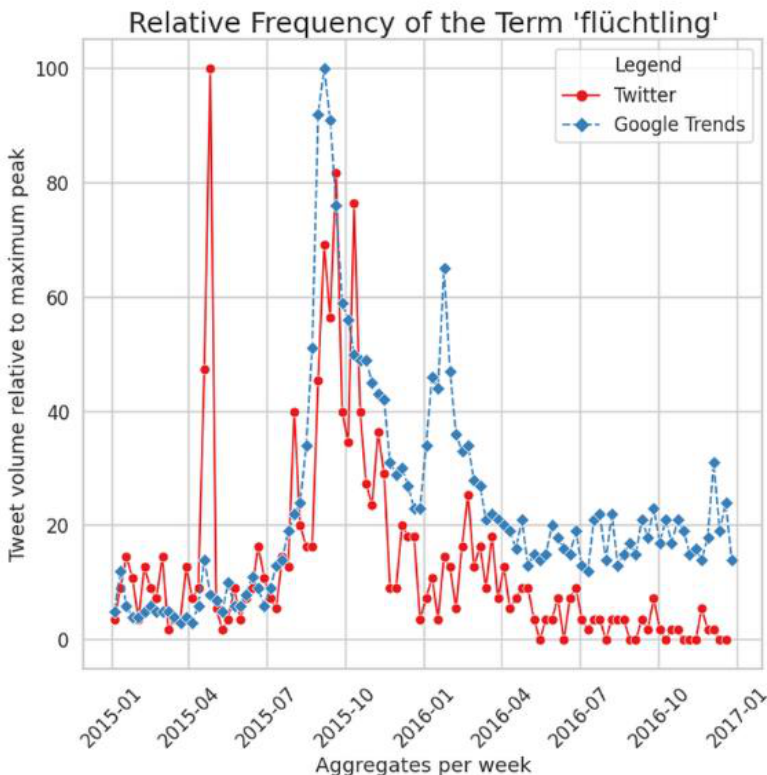
Figure 8. Relative frequency of tweets containing the German keyword “flüchtling” (red, solid line) compared to the relative frequency of search queries for that term on the Google search platform (blue, dotted line) for the Geo-Tweets.